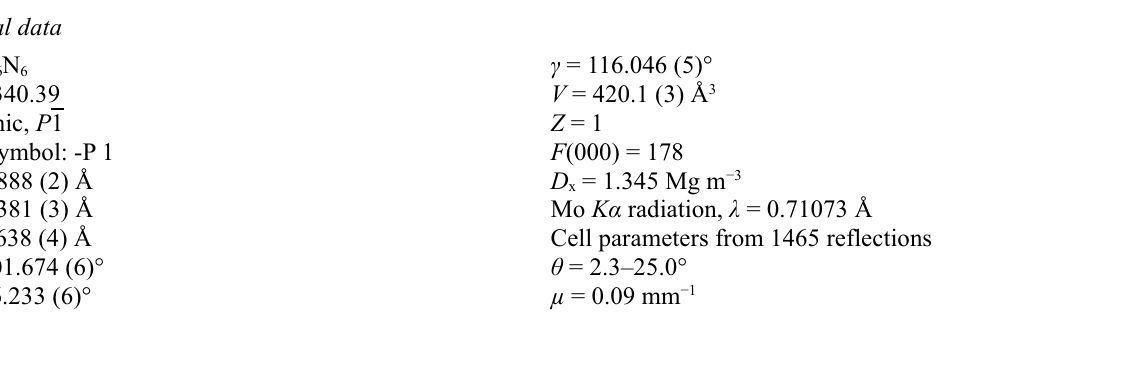
Pairs of (C–)H···N interactions lead to a layer structure along the a axis. N , N ′ -Bis[( E